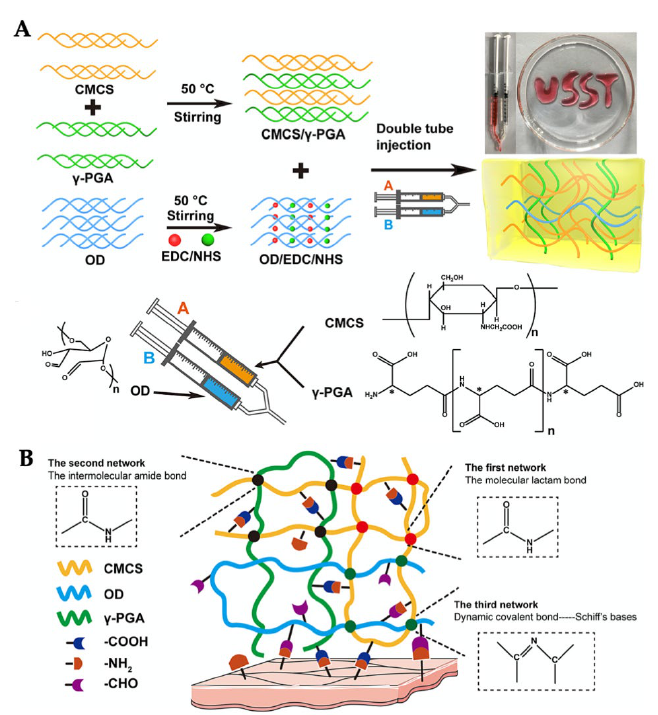
Figure 5. Schematic illustration of synthesis ( A ) and triple-network structure of carboxymethyl chitosans (CMCs), crosslinked by oxidized dextran (OD) and poly- γ - glutamic acid (γ -PGA) ( B ) (red dots: intramolecular amide bonds; black dots: intermolecular amide bonds; green dots: Schiff base bonds;) [reprinted with permission from ref. [155,156] Copyright 2022, Elsevier].